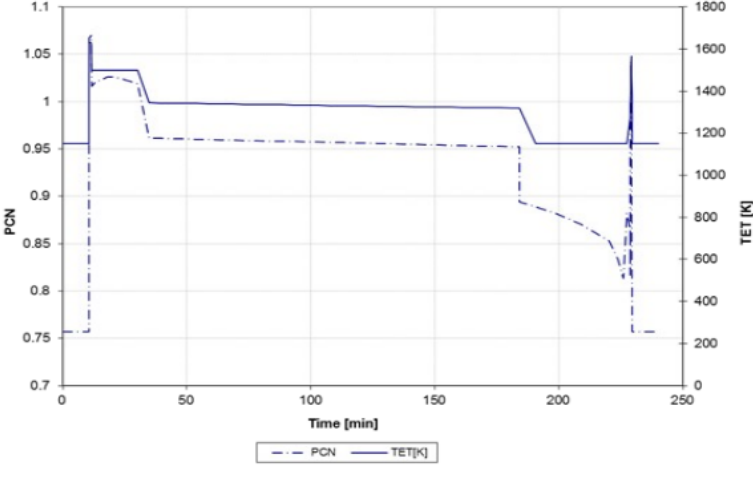
Figure 3: HPT blade RPM and TET